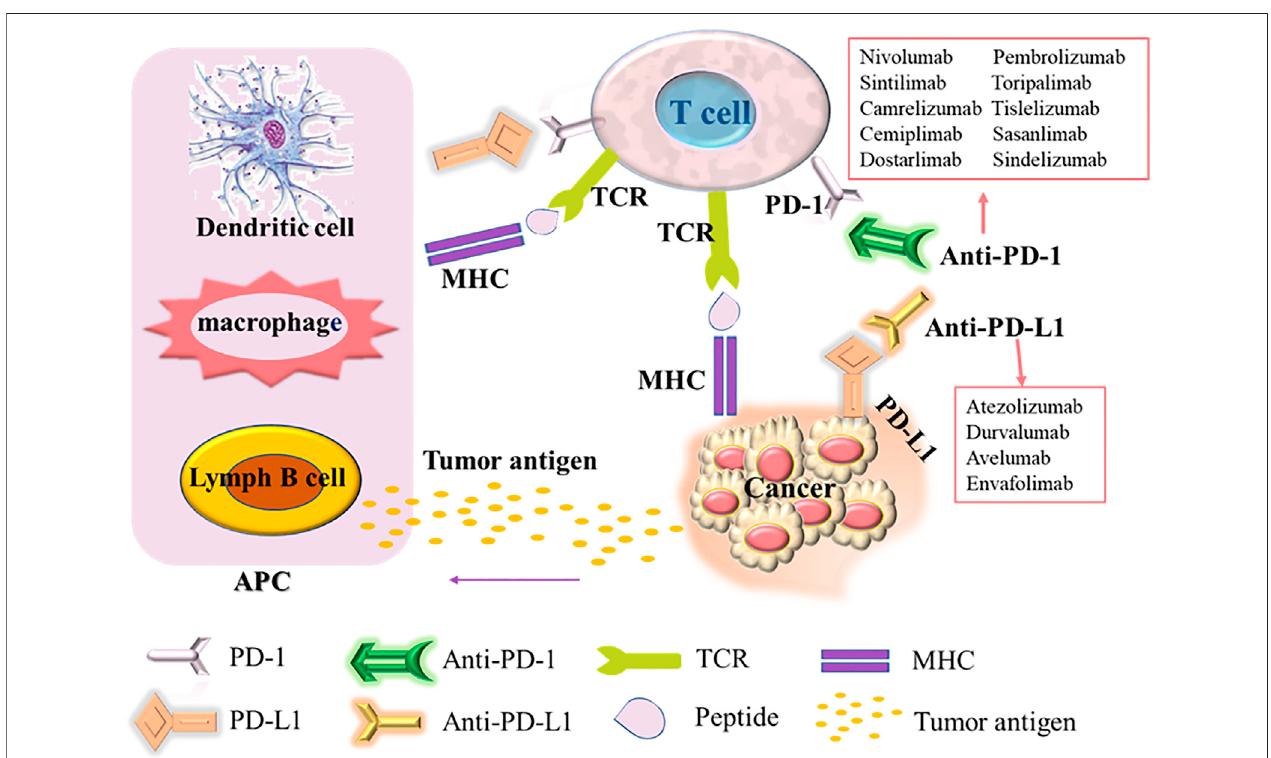
FIGURE 1 | Mechanism of action of PD-1/PD-L1